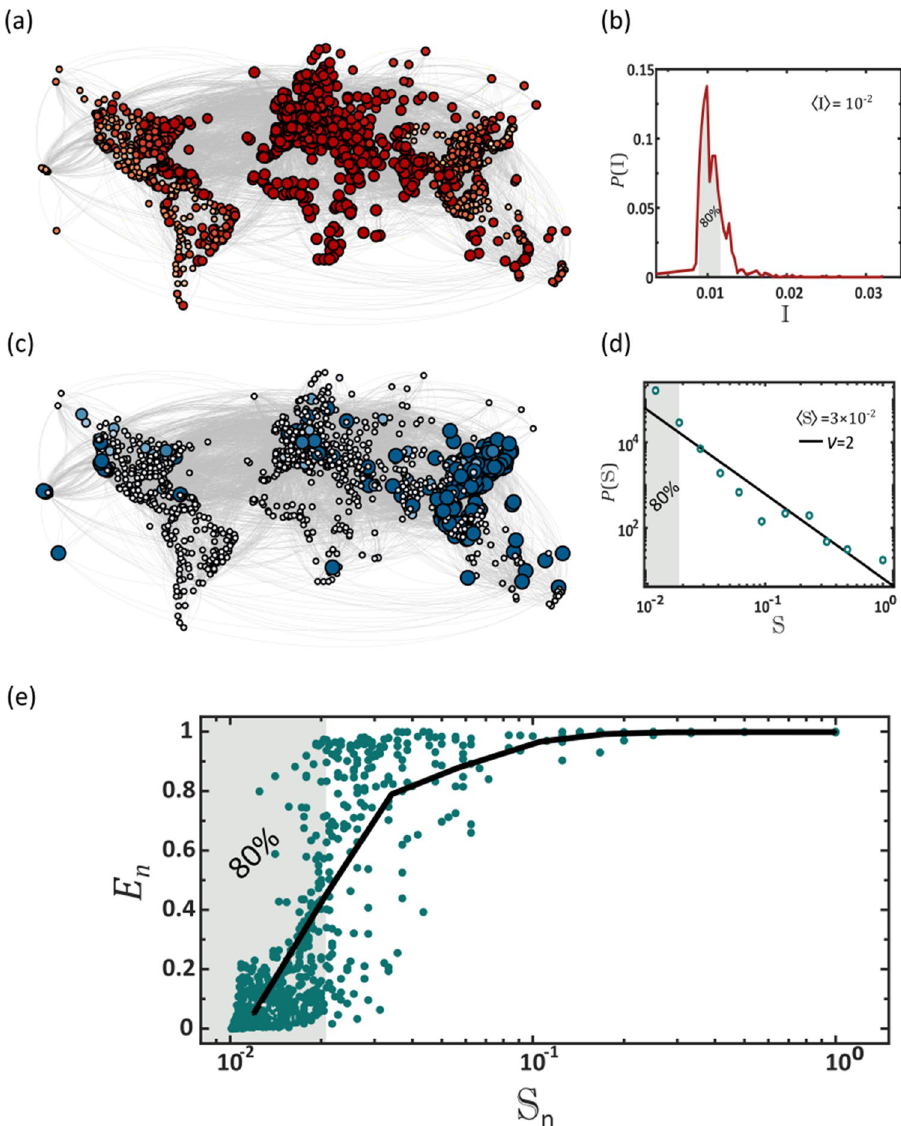
Figure 3. Why max-flow provides sub-optimal mitigation. ( a ) Pathogens spread via contagion dynamics, reproducing in each desination independently via the SIR process. The result is a relatively homogeneous spread, in which the majority of destinations reach peak infection (red) at approximately the same time. Here this is observed by the almost uniform red shade and size of all nodes, capturing the instantaneuous infection levels j n ( t ) during the time of global peak infection. ( b ) To quantify this we measure the infection rate I n of all nodes as obtained from Eq. (8), and plot its distribution P ( I ) . The bounded form of P ( I ) indicates the homogeneous nature of the pathogen spread. Indeed, we find that 80% of the nodes are impacted wthin a small margin around the average (shaded area). ( c ) Using max-flow we track the availability of the therapeutics q n ( t ) at all destinations (node size/blue color depth). In contrast to the pathogens, the therapeutics naturally spread extremely unevenly, with a small minority of early supplied nodes (large, dark blue), coexisting alogside a majority of delayed destinations (small, light blue). ( d ) The supply rate distribution P ( S ) as obtained via max- flow (circles). As predicted in Eq. (10), P ( S ) can be approximated by a power-law P ( S ) ∼ S − ν , with ν = 2 (solid line). This captures an extremely heterogeneous dissemination pattern, in which 80% of the nodes are supplied at a below average rate (shaded area). Hence, max-flow confronts a homogeneous demand ( j n ( t ) , red) with an extremely hetergeneous supply ( q n ( t ) , blue). ( e ) The local efficiency E n vs. supply rate S n as obtained via max- flow dissemination. As expected we find that S n crucially impacts the mitgation effectiveness at n . Therefore, the fat-tailed nature of P ( S ) , in which the majority of nodes have a small S n (80%, shaded) creates an intrinsic mitigation defficiency, in which most destinations experience insufficient supply. The challenge, we emphasize, is not in the production/shipping capacities, as indeed we have � S � ≈ � I � ≈ 10 − 2 , namely, that on average, supply rate can meet the evolving demand. Rather, is is rooted in the patterns of spread of the existing supply, which are fundamentally incongruent with those of the